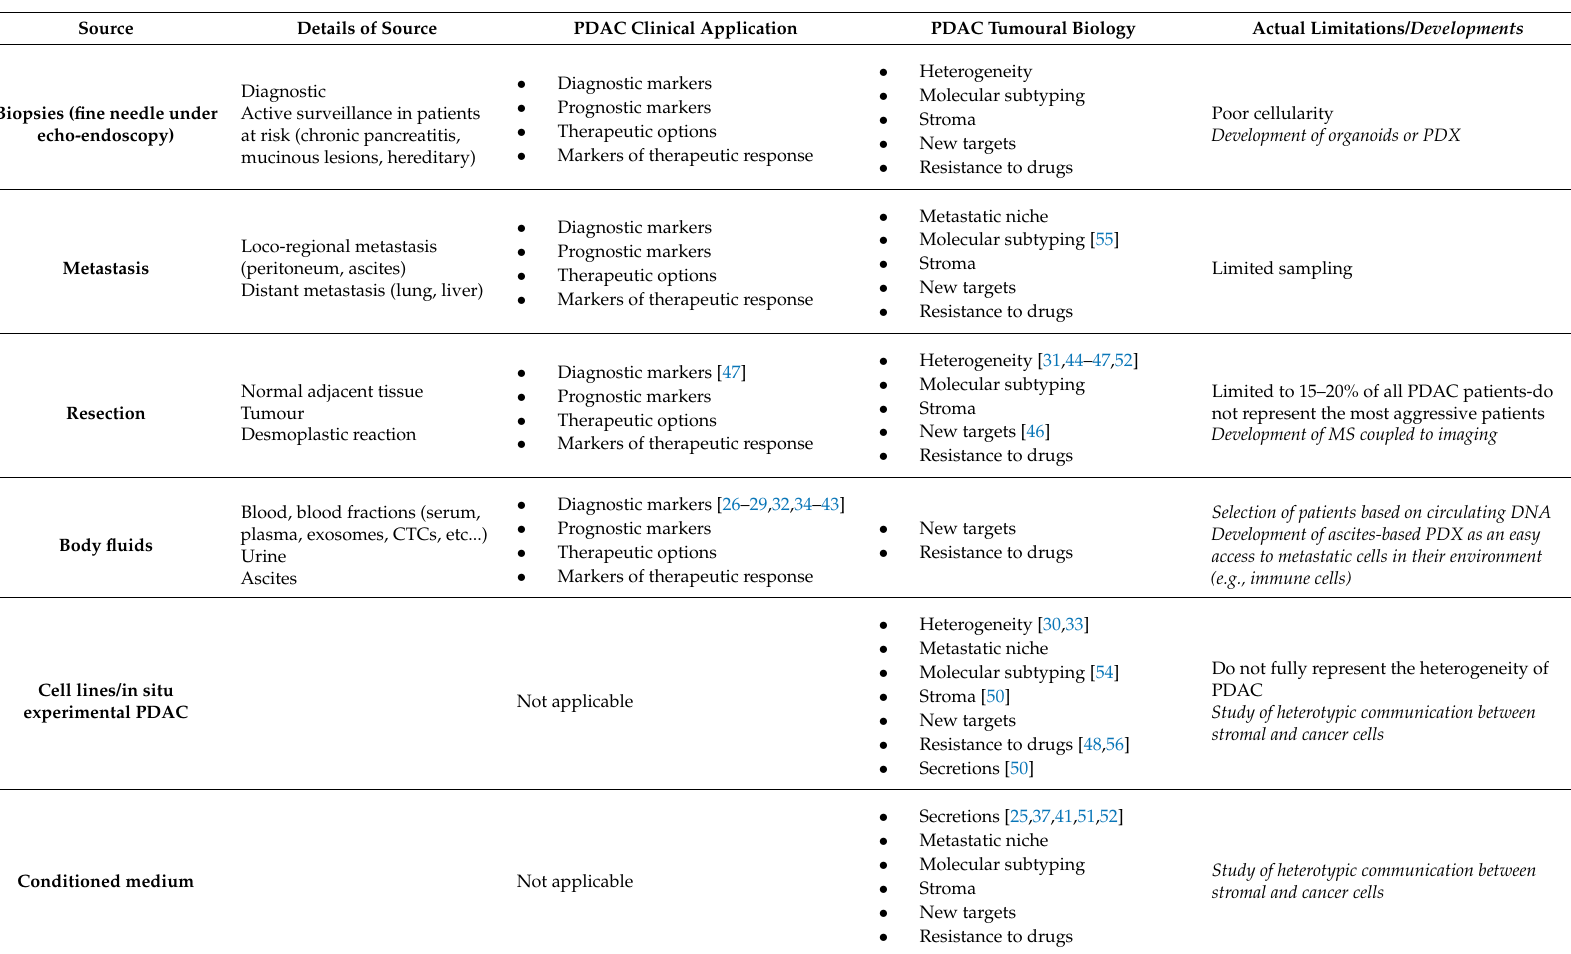
Table 1. Open questions in PDAC research that could be addressed by applying proteomics to a large range of biological samples. CTC: circulating tumoral cell; PDX: patient-derived